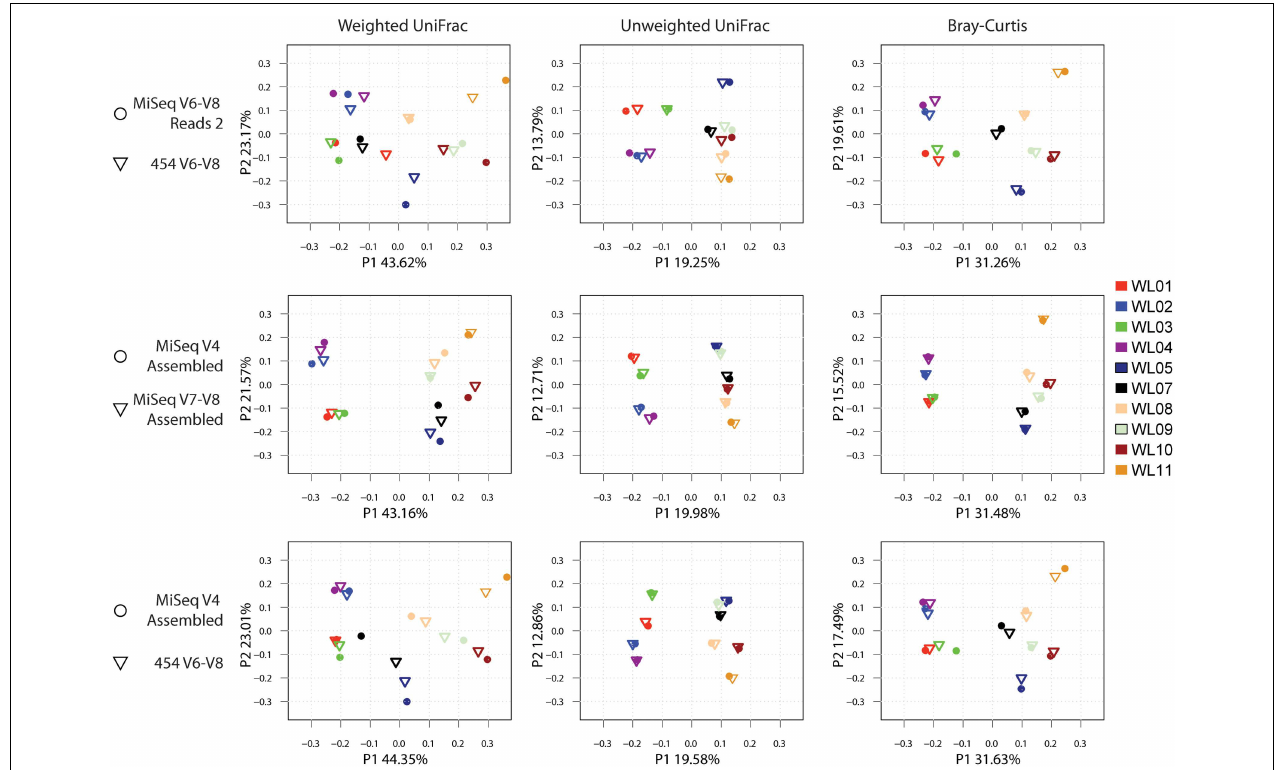
FIGURE 5 | Procrustes rotation comparison of weighted UniFrac, unweighted UniFrac and Bray-Curtis coordinates metrics for various wetland 16S tag data types.